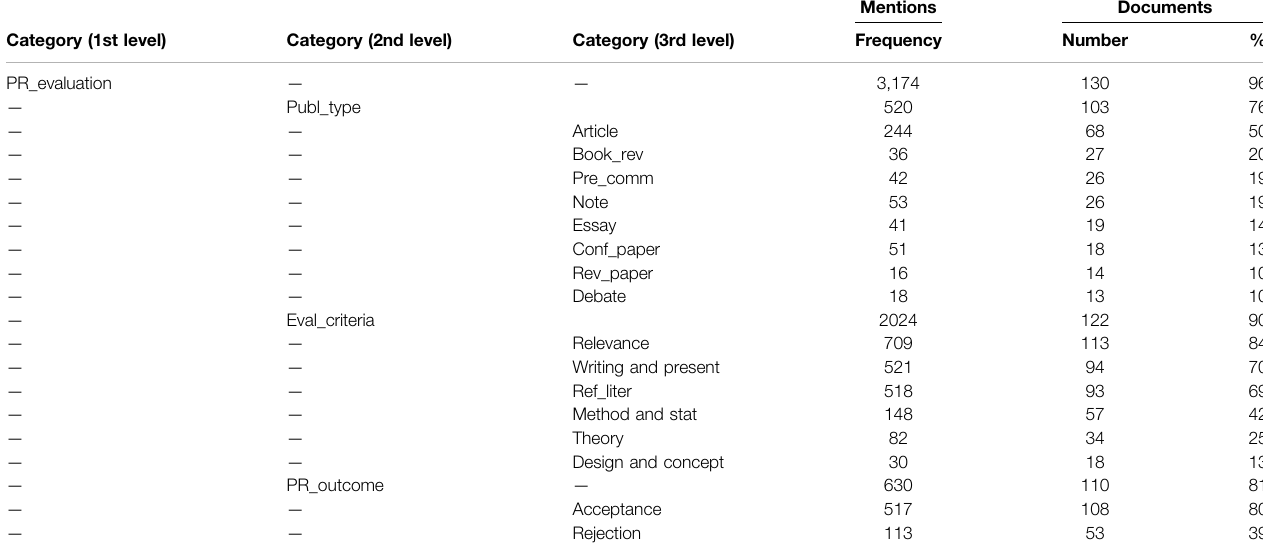
TABLE 4 | Peer review evaluation criteria categories (found in more than 10% of the